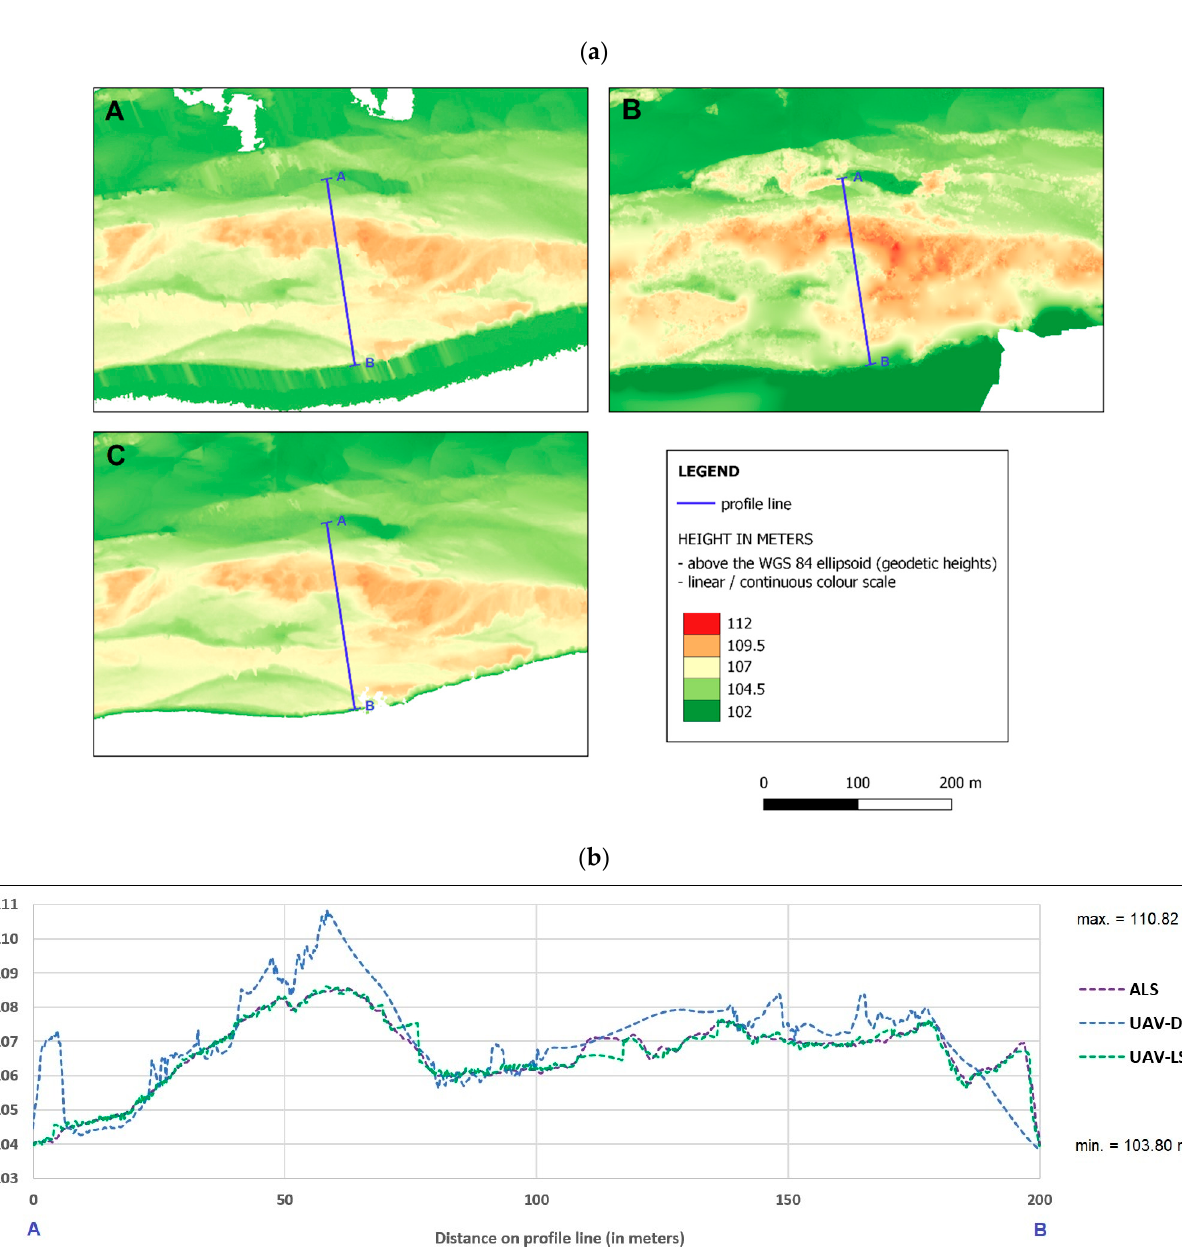
Figure 13. ( a ) Northern Island cross-section used to make the profile graph, image A —ALS, image B —UAV-DAP, image C —UAV-LS (ULS), ( b ) Northern Island—profile lines comparing three digital terrain models (DTMs). The measurement values are in metres, WGS84 ellipsoidal (geodetic heights). The details of the profiles show that both LiDAR-derived DTMs (ALS and ULS) carry almost the same level of accuracy. While in Figure 13 they are compared with the UAV-DAP DTM, in Figure 14 only the terrain profiles from the laser scanning “point cloud” models are intentionally shown. Figure 13 reveals that the UAV-DAP model diverges much from the others, and usually overestimates, both in elevated places (island ridges)—on sediment bars with lots of shrubs and short vegetation—and in depressions, especially at the land- water boundary where elevation anomalies might occur as a result of the photogrammetric